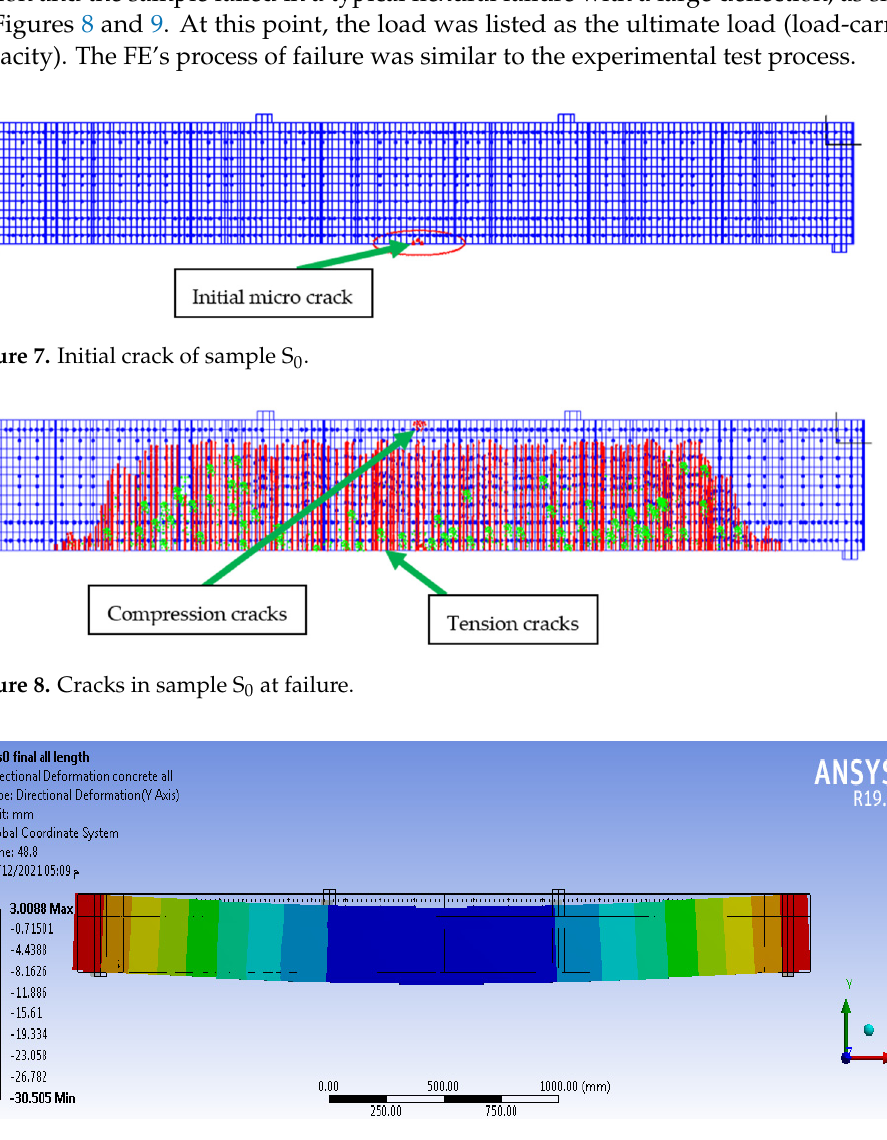
( c ) Figure 10. Load–deflection curves of experimental tests [1] and FE models: ( a ) sample S 1 , S 2 ; ( b ) sample S 3 , S 4 ; ( c ) sample S 5 , S 6 . 3.2. Verification with Harajli M. et al. Harajli M. et al. [19] tested 12 simply supported beam specimens with T-sections over a 3.0 m span, as shown in Figure 11. The specimens were divided into four groups, each containing two externally pre-stressed beams and one without pre-stressing. Two exter- nally pre-stressed RC beams, T2S and T4S, were used for the analysis and verification. Beam T2S was from the second group, while beam T4S was from the fourth group. No deviator is provided in beams T2S and T4S. Beams T2S and T4S feature a straight tendon profile with eccentricity equal to 84 mm along the full span. A summary of the material parameters of these beam specimens is provided in Table 1. 0204060 80